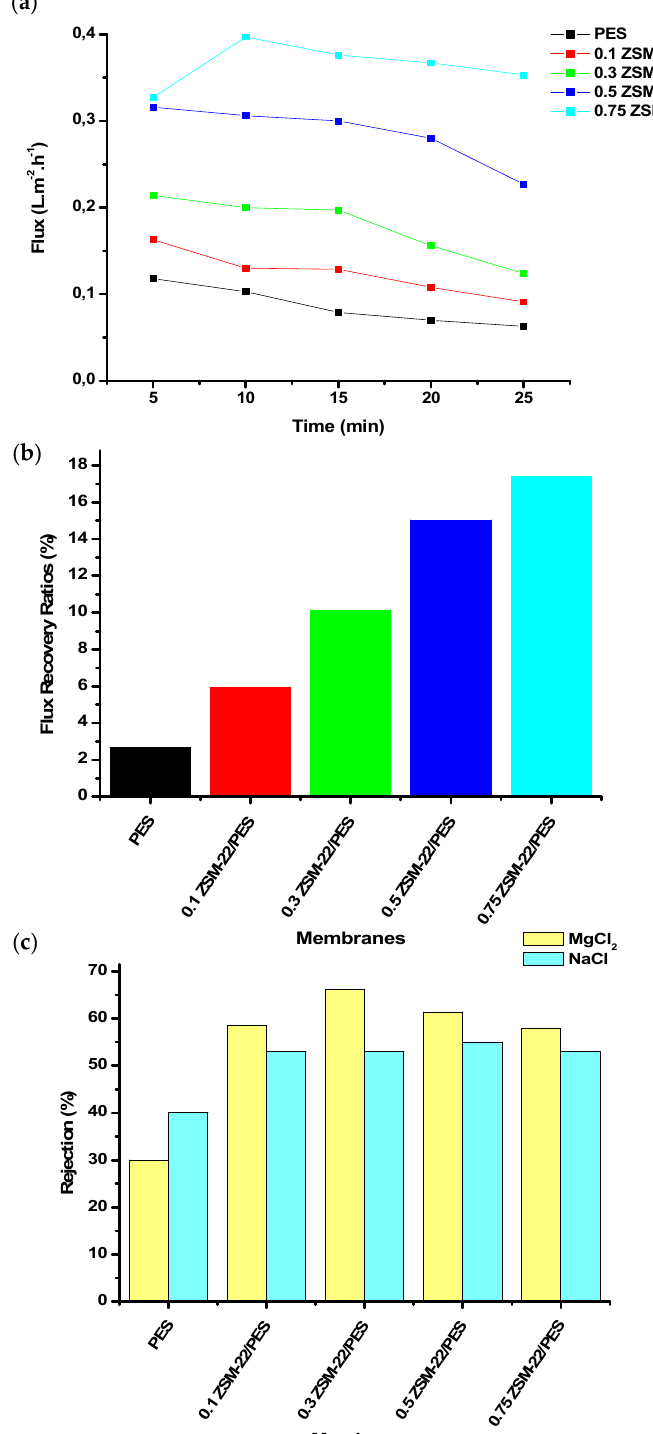
Figure 7. Performance evaluation. ( a ) Pure water flux, ( b ) flux recovery ratio and ( c ) salt rejection analysis graphs of di ff erently loaded ZSM-22 / PES membrane materials prepared using ZSM-22 as a